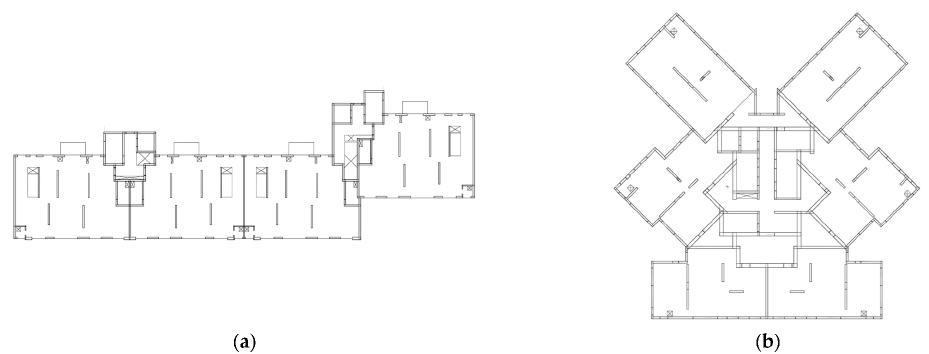
Figure 6. Examples of each classification according to the shape of the slab: ( a ) regular shape of slab; ( b ) irregular shape of slab. Table 12. Results of classifying each slab of a building into a regular or irregular shape. Shape of Slabs Regular Irregular